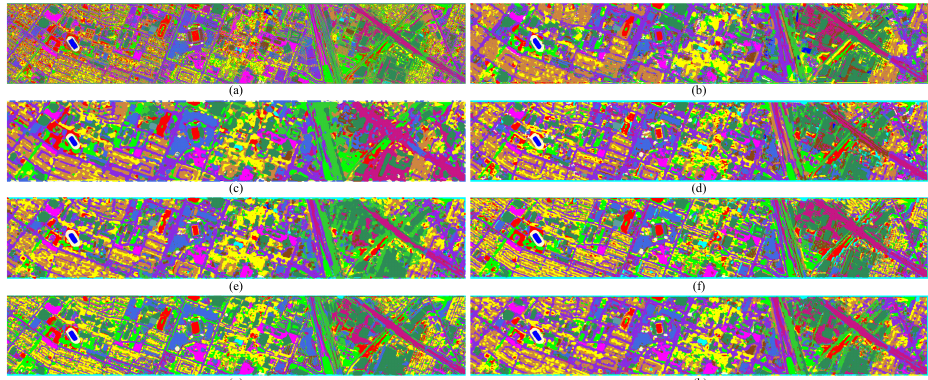
Figure 9. Classification maps of the UH data set obtained by: ( a ) SVM, ( b ) RNN, ( c ) SSRN, ( d ) DFFN, ( e ) RSSAN, ( f ) CBW, ( g ) SSAN, ( h )